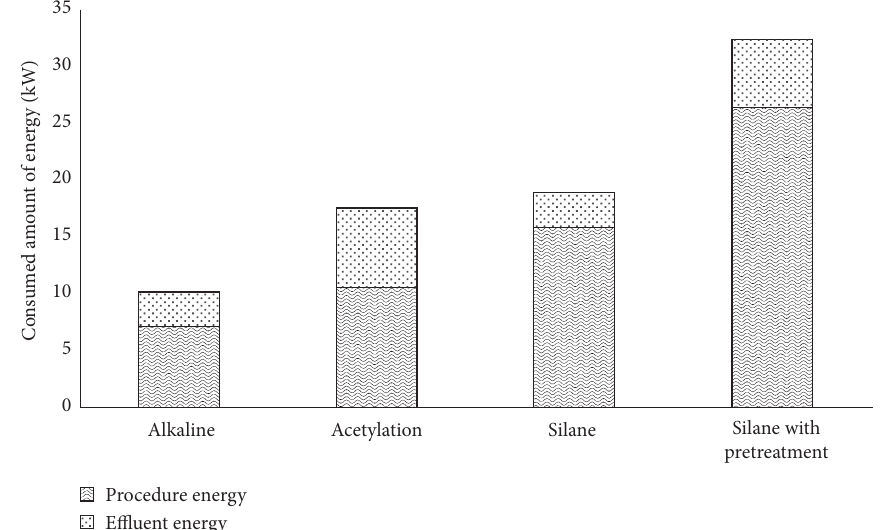
Figure 8: Energy intake for various chemical treatments per unit of natural fiber Table 3: Applications of the biocomposite [82].